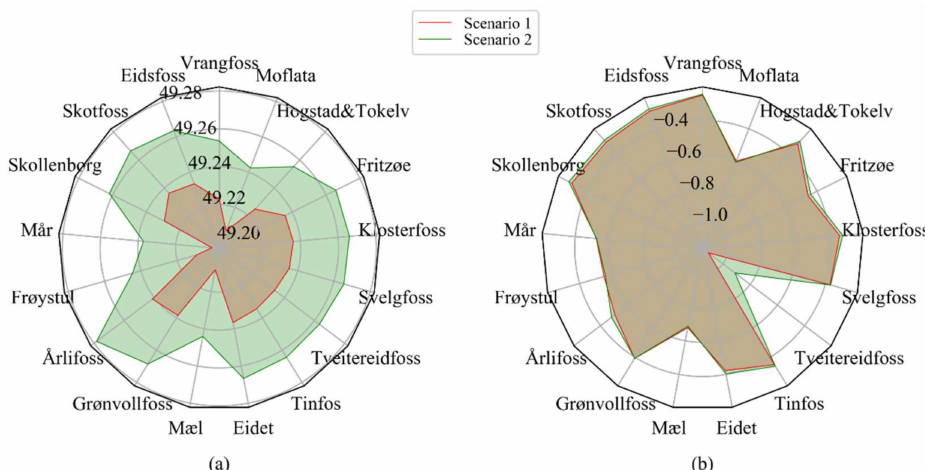
Figure 13. Frequency indicators of the synchronous generators in operation for Scenario 1 and Scenario 2 of the year 2030: ( a ) minimum frequency ( f min ) and ( b ) Maximum ROCOF.